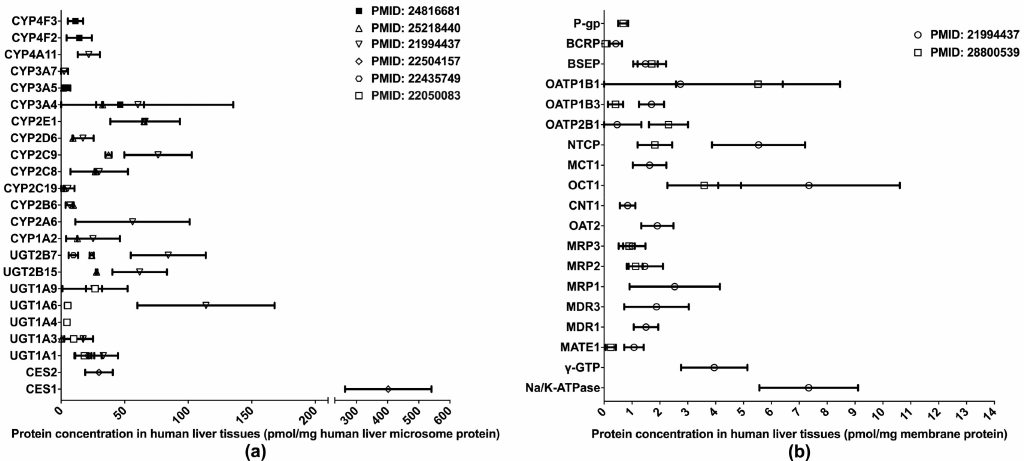
Figure 1. Absolute quantification of major clinically relevant human hepatic drug-metabolizing enzymes ( a ) and transporters ( b ). Protein expression levels are presented as means with standard deviations. CYP: cytochromes P450; UGT: uridine 5 (cid:48) -diphospho-glucuronosyltransferase; CES: carboxylesterase; P-gp, P-glycoprotein; BCRP, breast cancer resistance protein; BSEP: bile salt e ffl